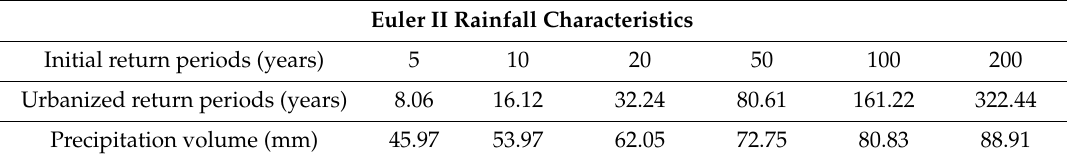
Table 4. Rainfall characteristics used for the hydraulic evaluation of networks .